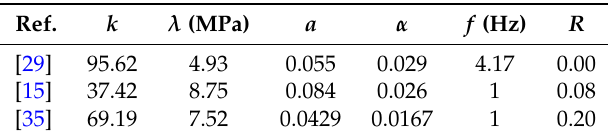
Table 4. Measured flexural strength, f r , by Johnston and Zemp [41], Singh et al. [42], Mohammadi and Kaushik [17] and Goel and Singh [44]. The two-million cycle endurance limit σ min fiber-reinforced self-compacting concrete (SCC), Goel and Singh 2014